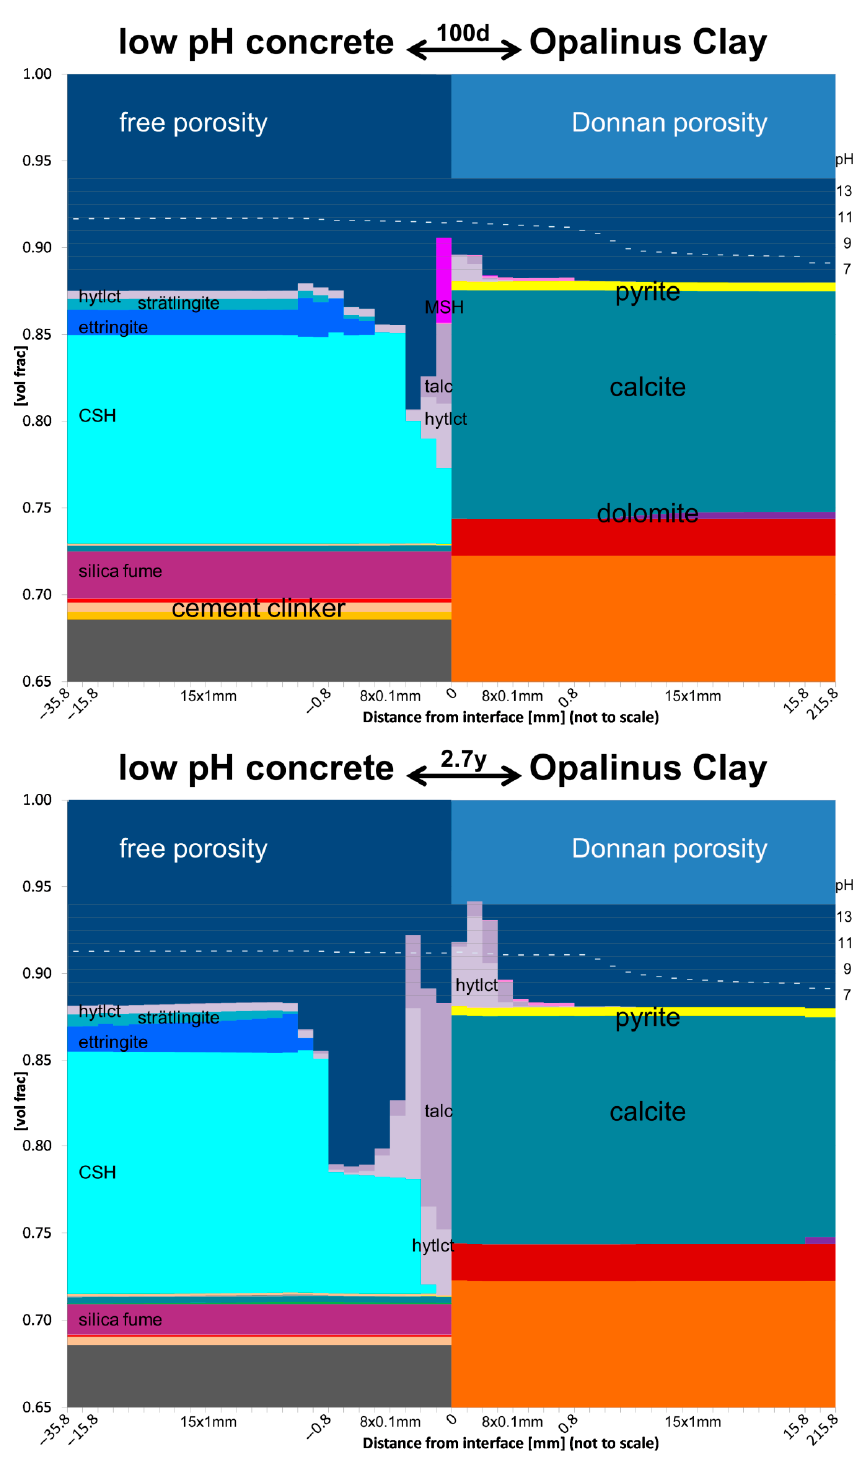
Figure 2. Predicted volume evolution of the reactive phases (legend and explanation of horizontal axis in Figure 1 and captions). The pH of the free porewater is indicated in the dark blue free porosity area.